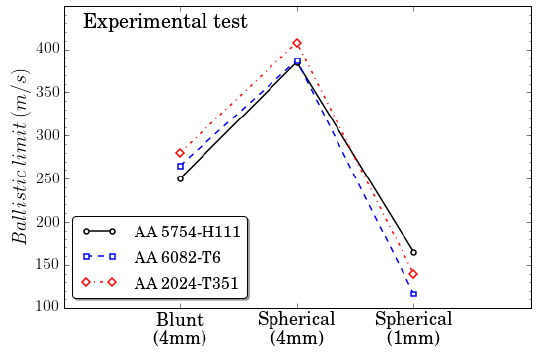
Figure 19. Ballistic limit velocity V bl versus projectile nose shape for the three materials